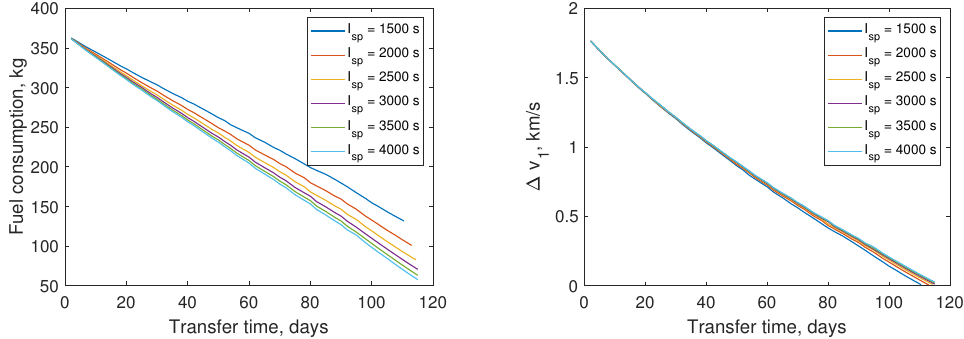
Figure 8. The variation in fuel consumption with transfer time and variation in magnitude of impulsive burn with transfer time for different values of I sp when T max = 200